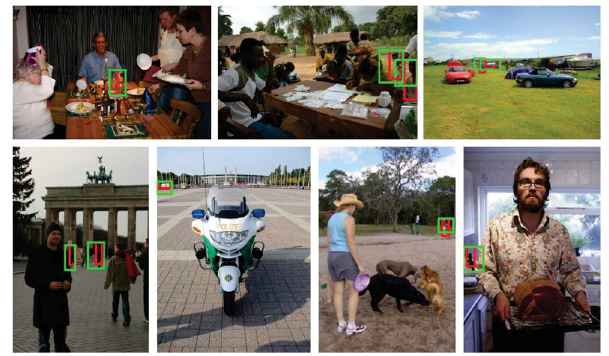
Fig. 5 Some failure examples of BING-E. Failure means that the overlap between the best detected box (green) and ground truth (red) is less than 0.5. All images are from the VOC2007 test set.